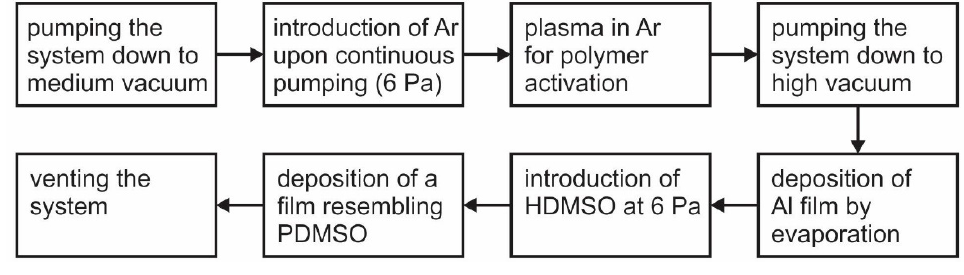
Figure 1. Schematic of the coating procedure.